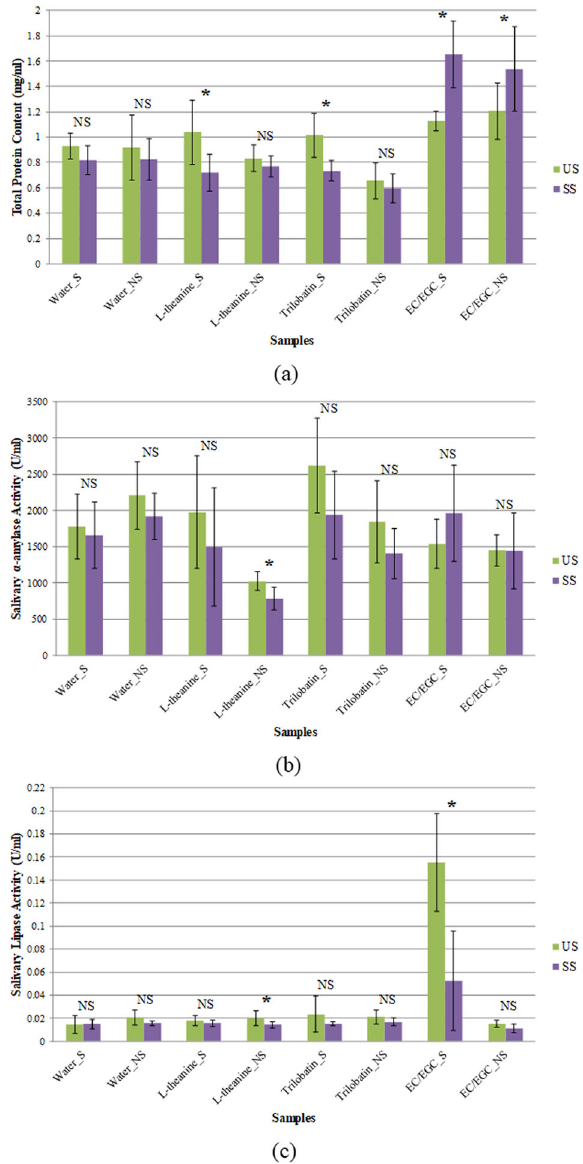
Fig. 2 The change of salivary component as affected by the consumption of samples by sensitive and non-sensitive group. a – c The total protein content of saliva, salivary α -amylase, and lipase activity, respectively. US and SS are the unstimulated and stimulated saliva before and after the consumption of sample, respectively; S and NS denote sensitive and non-sensitive group, respectively. An asterisk symbol and NS indicate signi fi cant and not signi fi cant difference within each sample of the particular sensory group, respectively. The error bars represent 95% con fi dence interval.